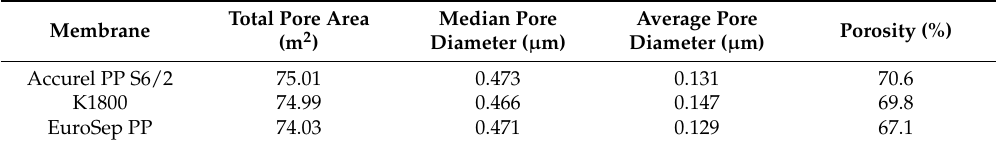
Figure 10. Distribution of pore sizes the studied capillary membranes. ( A ) Accurel PP S6/2, ( B ) K1800, and ( C ) EuroSep PP. Table 4. The results of mercury porosimetry measurements. Table 4. The results of mercury porosimetry measurements.